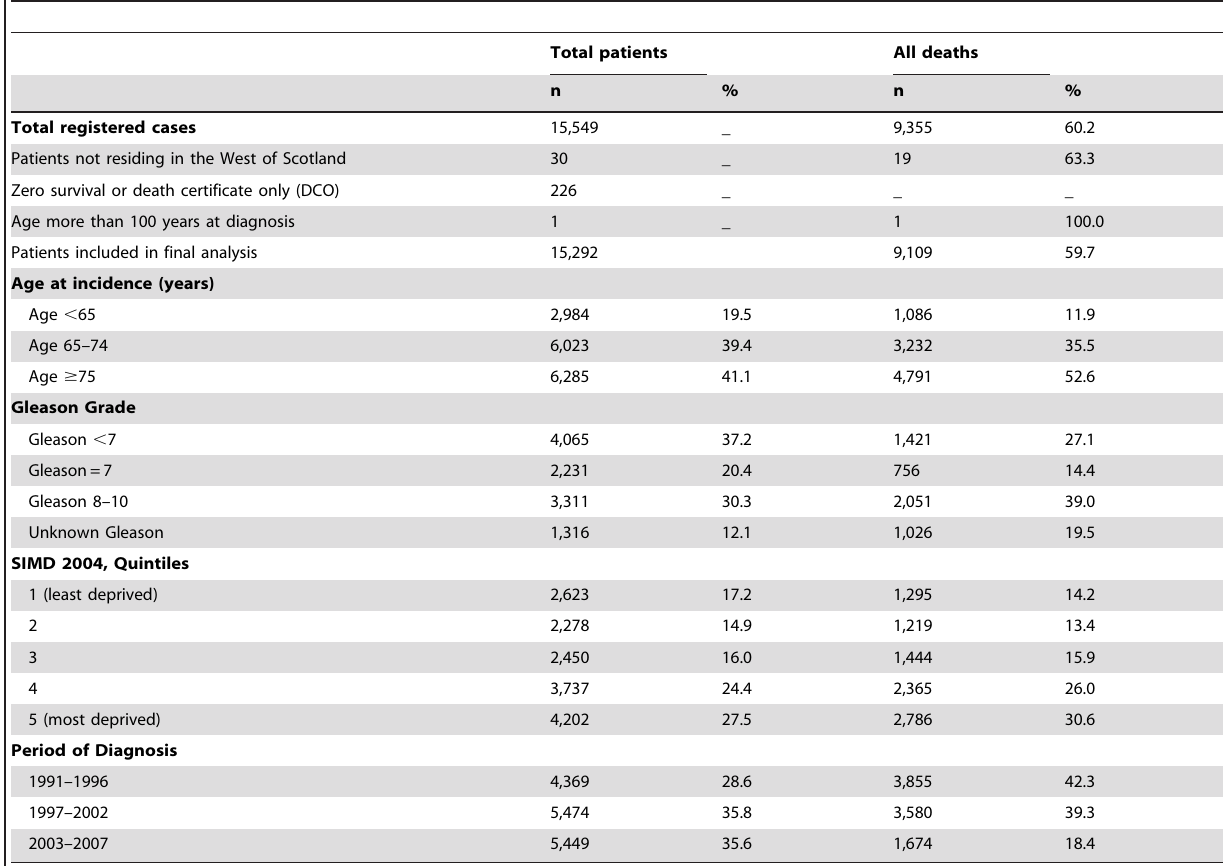
Table 1. Baseline characteristics of prostate cancer patients registered in the West of Scotland from